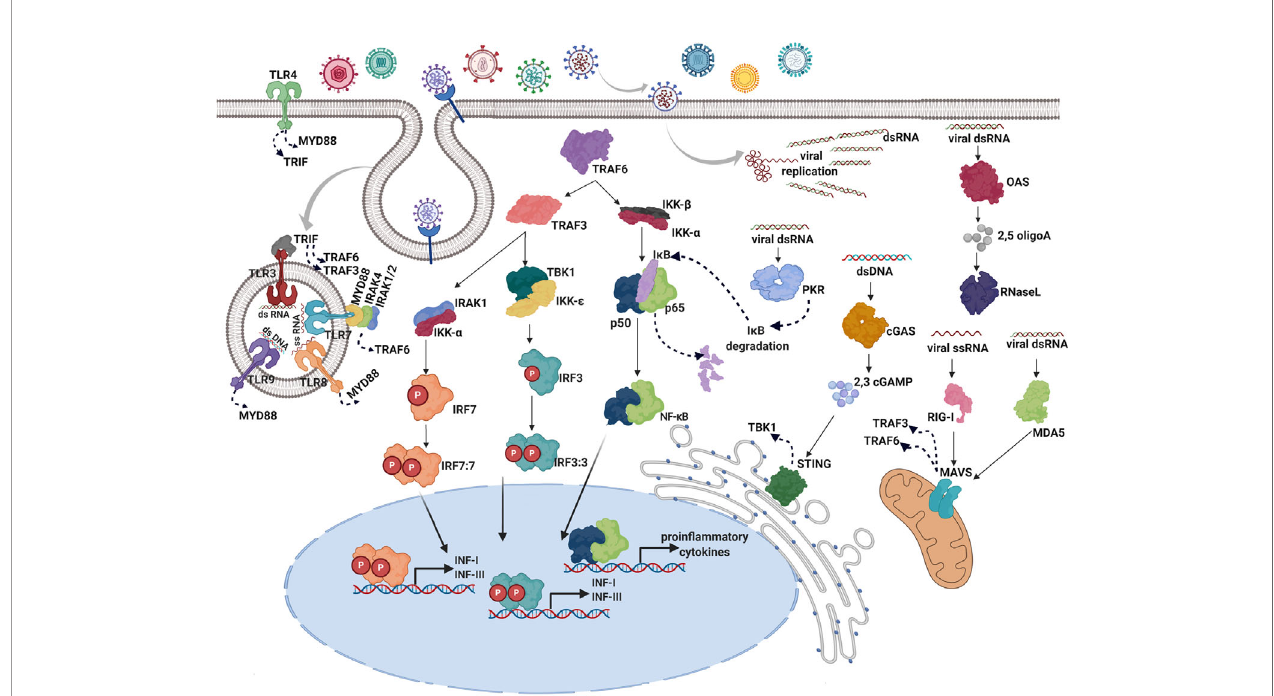
FIGURE 1 | Induction of type I IFNs in response to viral infections. After virus entry through cell membrane using receptors or membrane fusion strategies, the infected cell detects the presence of virus replication by PRRs. There are two IFN-inducing systems in response to viral PRRs: one system is ubiquitously expressed and localized in the cytoplasm (OAS, MDA-5, RIG-I, cGAS, and PKR), wherein viral nucleic acids produced upon infection are detected, the other one is restricted to endosomes of specialized sentinel cells and mediated by Toll-like receptor (TLR) family (TLR3,7,8,9) (12). In the cytosol, viral double-stranded (ds) RNA is recognized by melanoma differentiation-associated protein 5 (MDA-5), 2 ’ -5 ’ -oligoadenylate synthetase (OAS), and protein kinase R (PKR) whereas retinoic acid-inducible gene I (RIG-I) is specialized in single-stranded (ss) RNA detection. Cyclic GMP-AMP synthase (cGAS) acts as a double-stranded DNA sensor (27). In the endosomes, TLRs are transmembrane proteins that detect double-stranded RNA (dsRNA; TLR3), single-stranded RNA (ssRNA; TLR7 and TLR8), and double-stranded DNA (dsDNA; TLR9). Additionally, TLR4 is located on the cell surface, to detects viral glycoproteins (28). Activation of RIG-I and MAD-5 leads to activation of mitochondrial antiviral- signaling protein (MAVS) in the mitochondrion and the consequent signaling through TNF receptor associated factors (TRAFs) such as TRAF3 and TRAF6 (29). Detection of viral material by OAS leads to the synthesis of 2 ’ -5 ’ -oligoadenylates, which then act as intracellular second messengers to activate latent endoribonuclease (RNase L) reinforcing the innate response through indiscriminate cleavage of host and viral RNA and producing additional PAMPS (30). In response to the activation of the cGAS nucleotidyltransferase activity, cyclic GMP-AMP (cGAMP) is produced, which in turn binds to and activates the stimulator of IFN genes (STING) in the endoplasmic reticulum, inducing the TANK-binding kinase 1 (TBK1) activation (31). PKR activation leads to a dramatic reduction of host and viral translation and degradation of k B inhibitor (I k B), resulting in the activation of the NF- k B signaling pathway (32). Upon TLR viral recognition, activation of adapters, myeloid differentiation primary response 88 (MYD88) and TIR-domain-containing adapter-inducing interferon- b (TRIF) occurs, leading to the activation of TRAF6 and TRAF3 (33). Immediately upstream of the IRFs, I k B kinase ‑ ϵ (IKK ϵ ) and TANK-binding kinase 1 (TBK1) are responsible for the phosphorylation of IRF3 and IRF7 (34). Once activated IRF3, IRF7, and NF- k B are translocated to the nucleus where they bind to speci fi c binding sites, turning on the transcription of type I and III IFN genes and proin fl ammatory cytokines